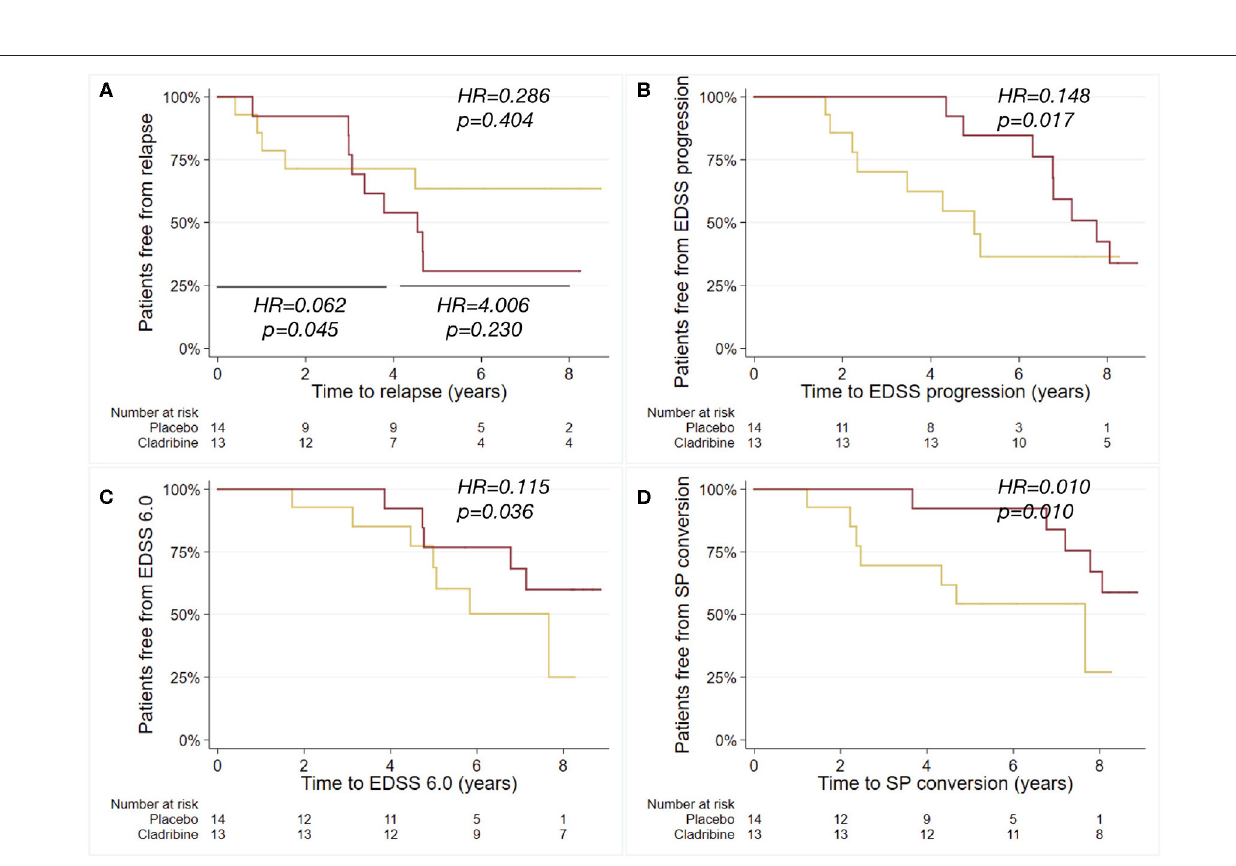
Frontiers in Neurology | www.frontiersin.org